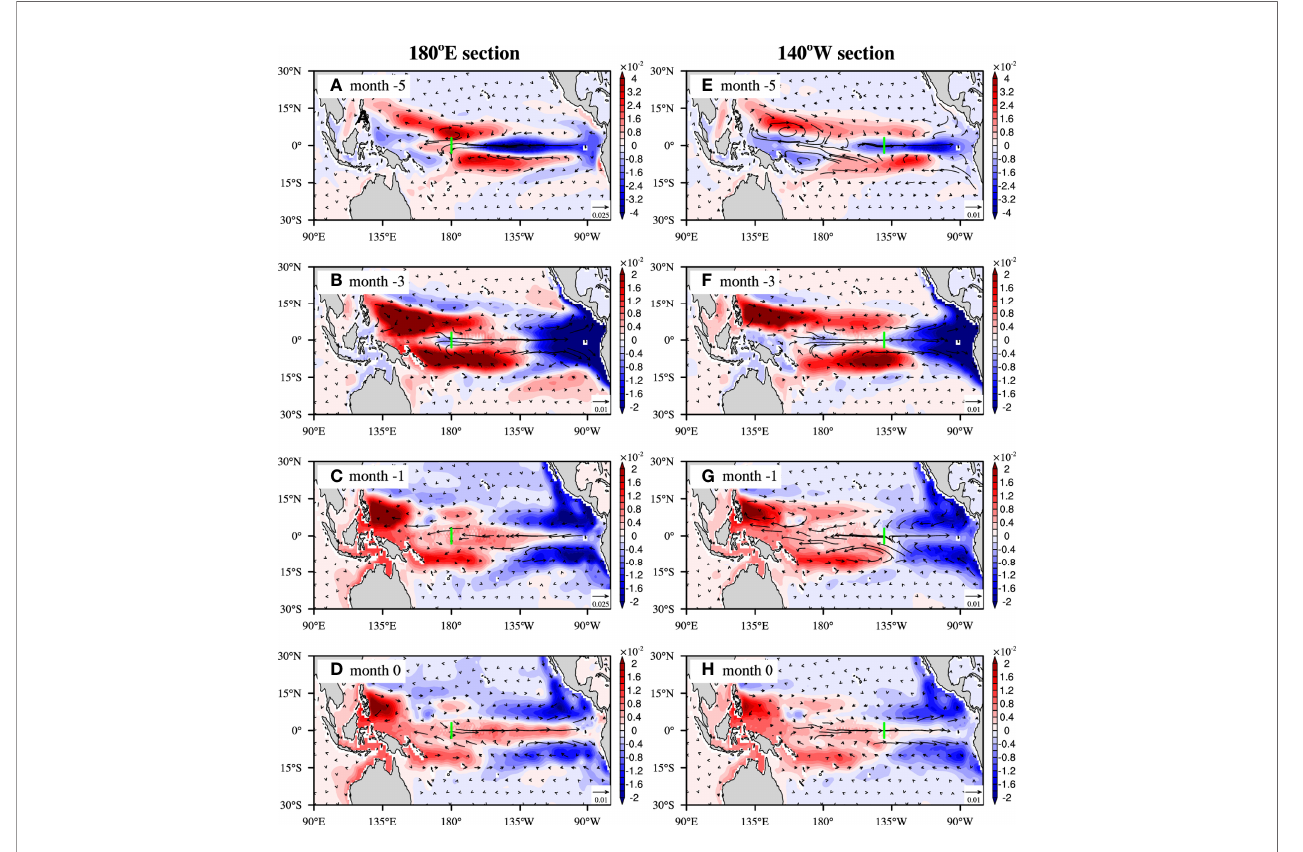
FIGURE 14 | Same as Figure 11 but for the target sections at (A – D) 180°E and (E – H) 140°W.